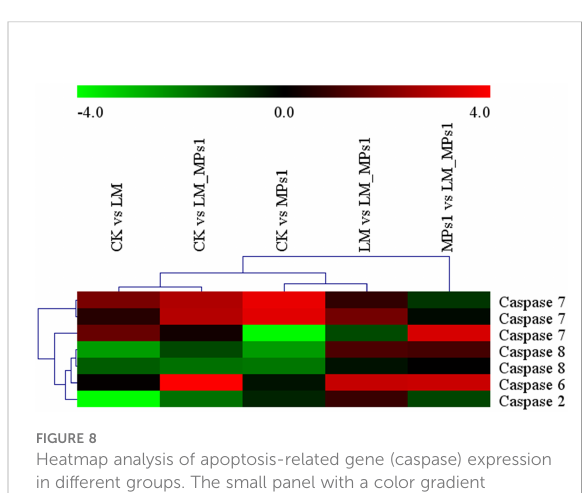
FIGURE 8 Heatmap analysis of apoptosis-related gene (caspase) expression in different groups. The small panel with a color gradient represents the changes in gene expression levels from down- regulated (green) to up-regulated